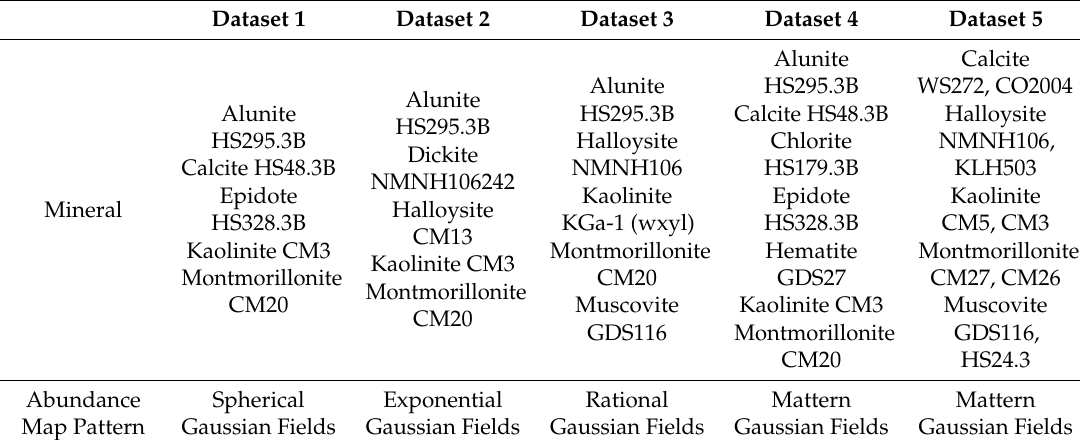
Table 1. The constituent spectra of the simulated images.